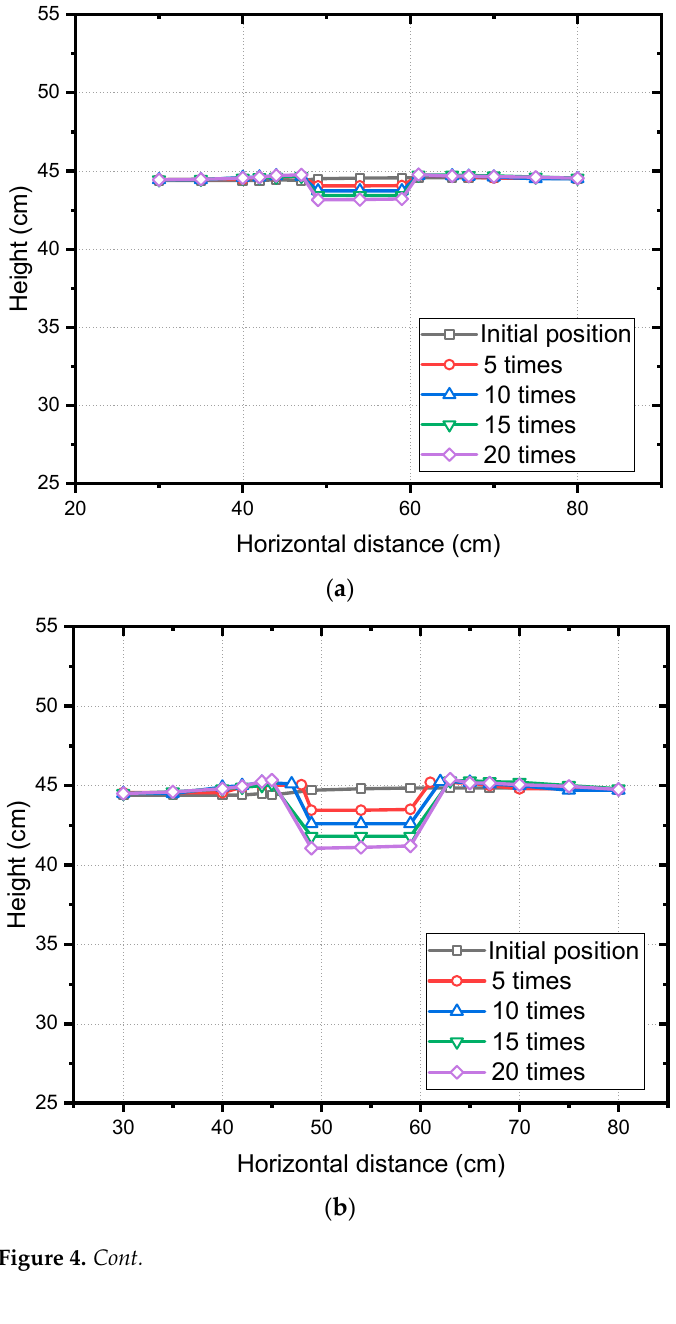
Figure 5a–c, as an example: the maximum displacements of three energy levels were about 0.8, 2, and 3.2 cm, respectively. Therefore, the displacement induced by DC could also reflect the energy levels in terms of the geometry of the crater.